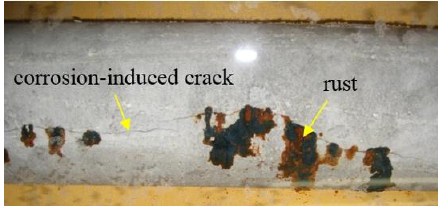
Figure 6. Photograph of typical cracks and rust in RC specimens after accelerated corrosion tests.